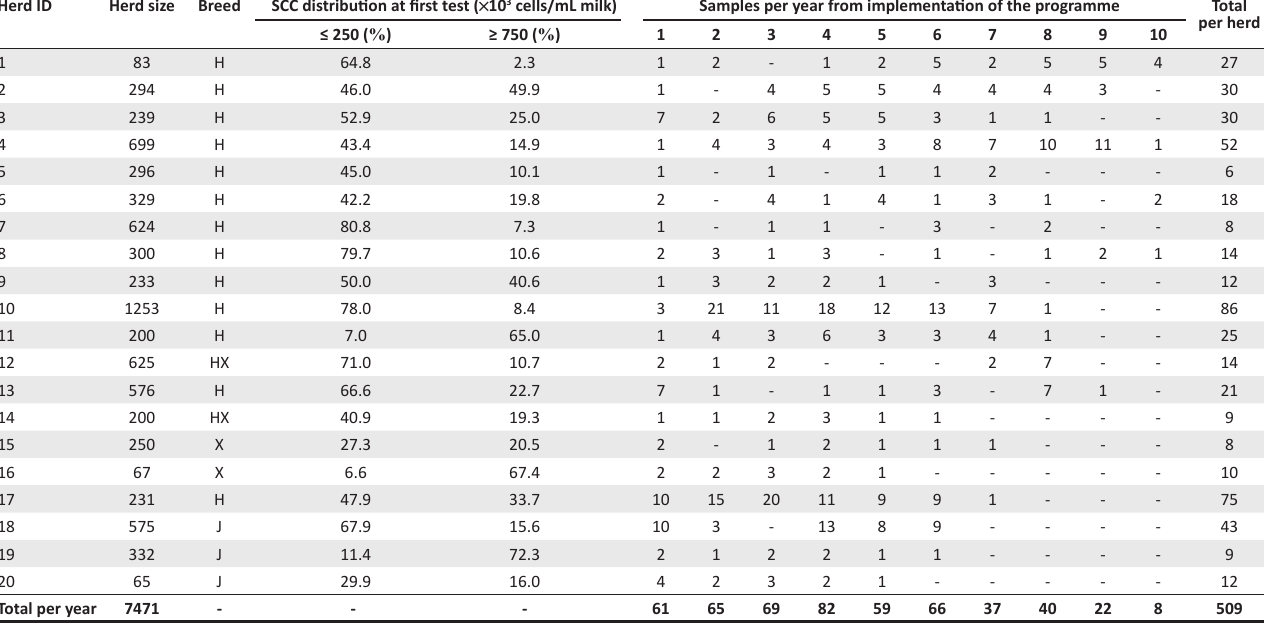
Herd ID Herd size